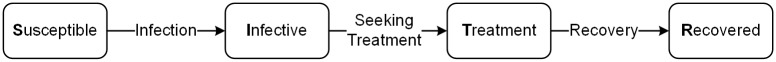
A model for the outbreak of a novel viral pathogen.